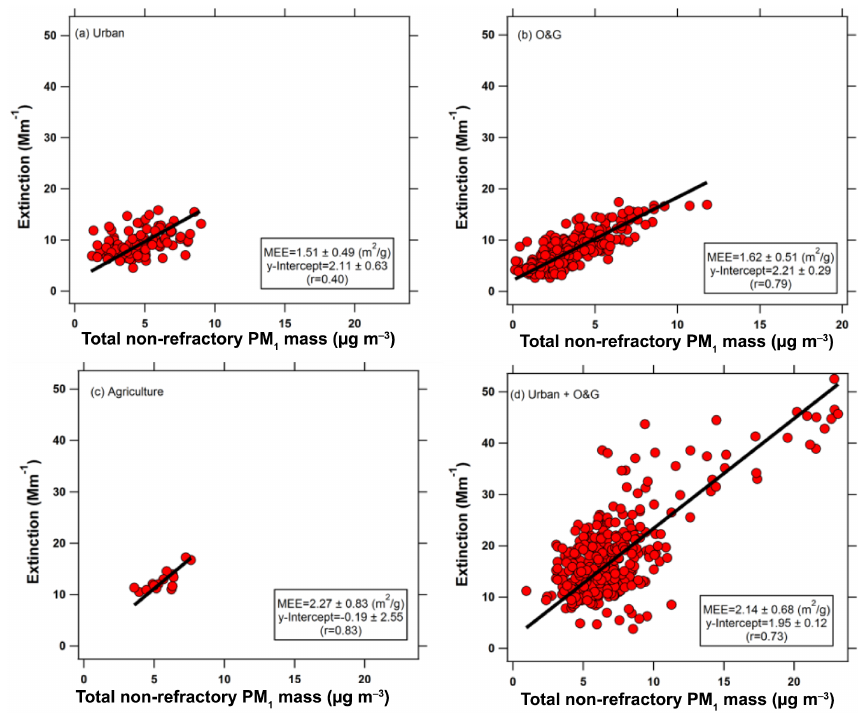
Figure 5. Mass extinction efficiencies (MEEs) under (a) urban, (b) O&G, (c) agriculture, and (d) urban + O&G influence.